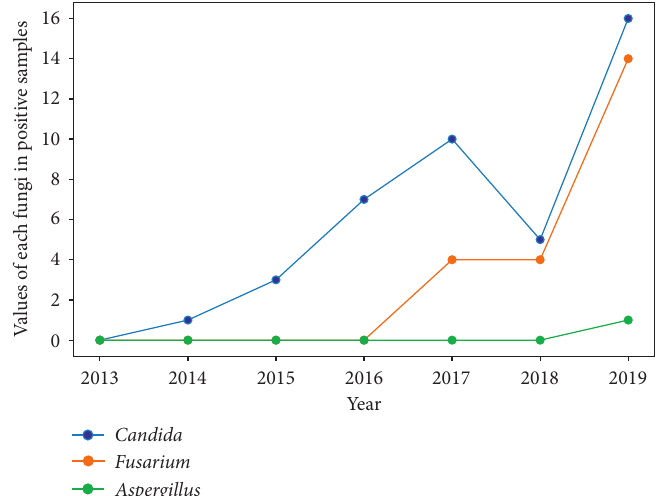
Figure 13: Values of each fungi in positive